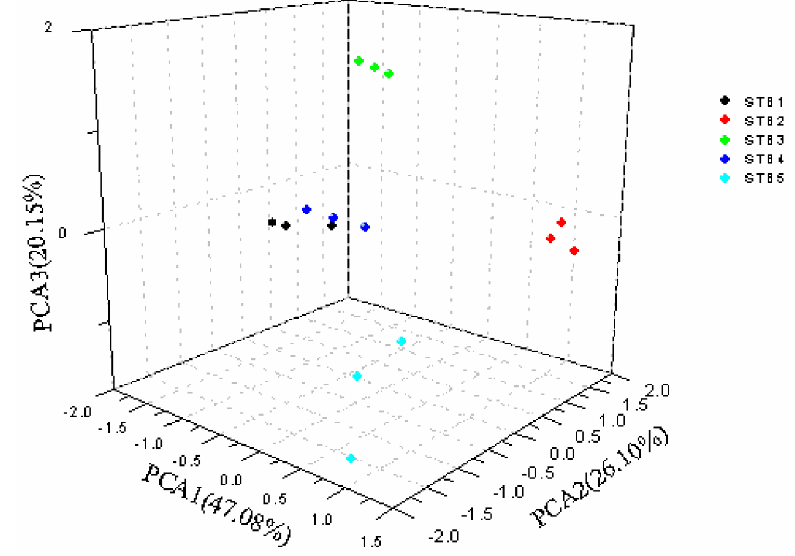
Figure 6. Principal component analysis of five brands of brine. Table 3. Rotational component matrix.